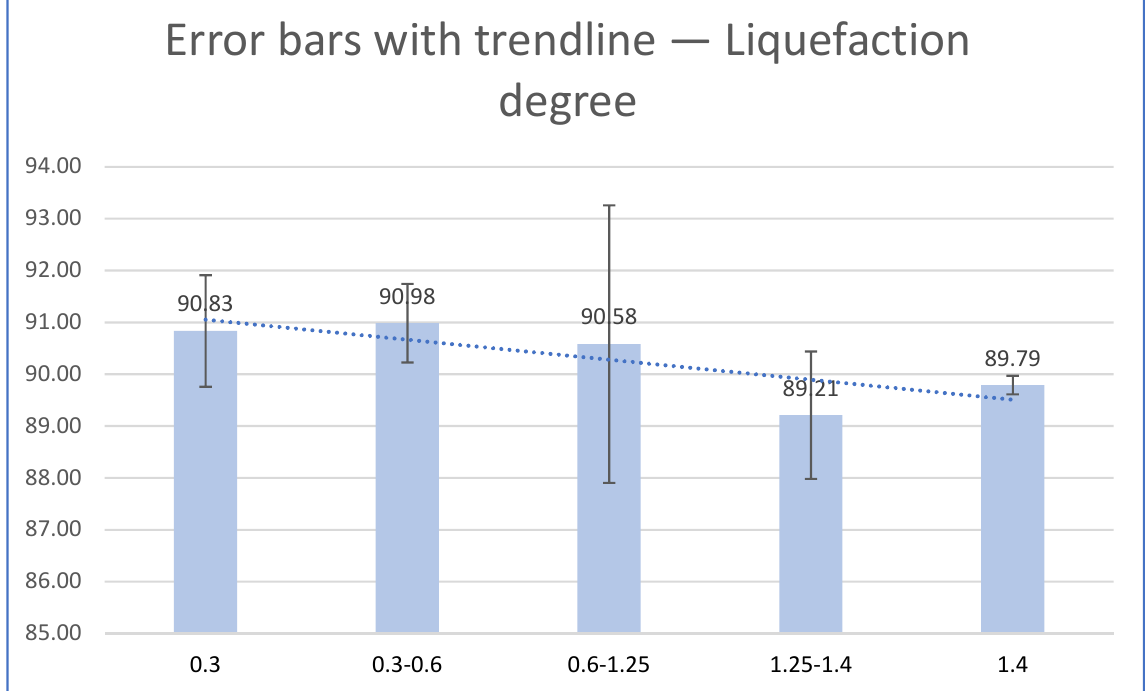
Figure 3. Liquefaction degree as a function of particle size. Obtained results have shown that liquefaction degree depends on particle size and with a decrease in granulation there is an increase in liquefaction degree. Among the lique- fied different biomass particle sizes, the lowest OH-number was achieved with granulation 0.3-0.6 mm (Figure 4).